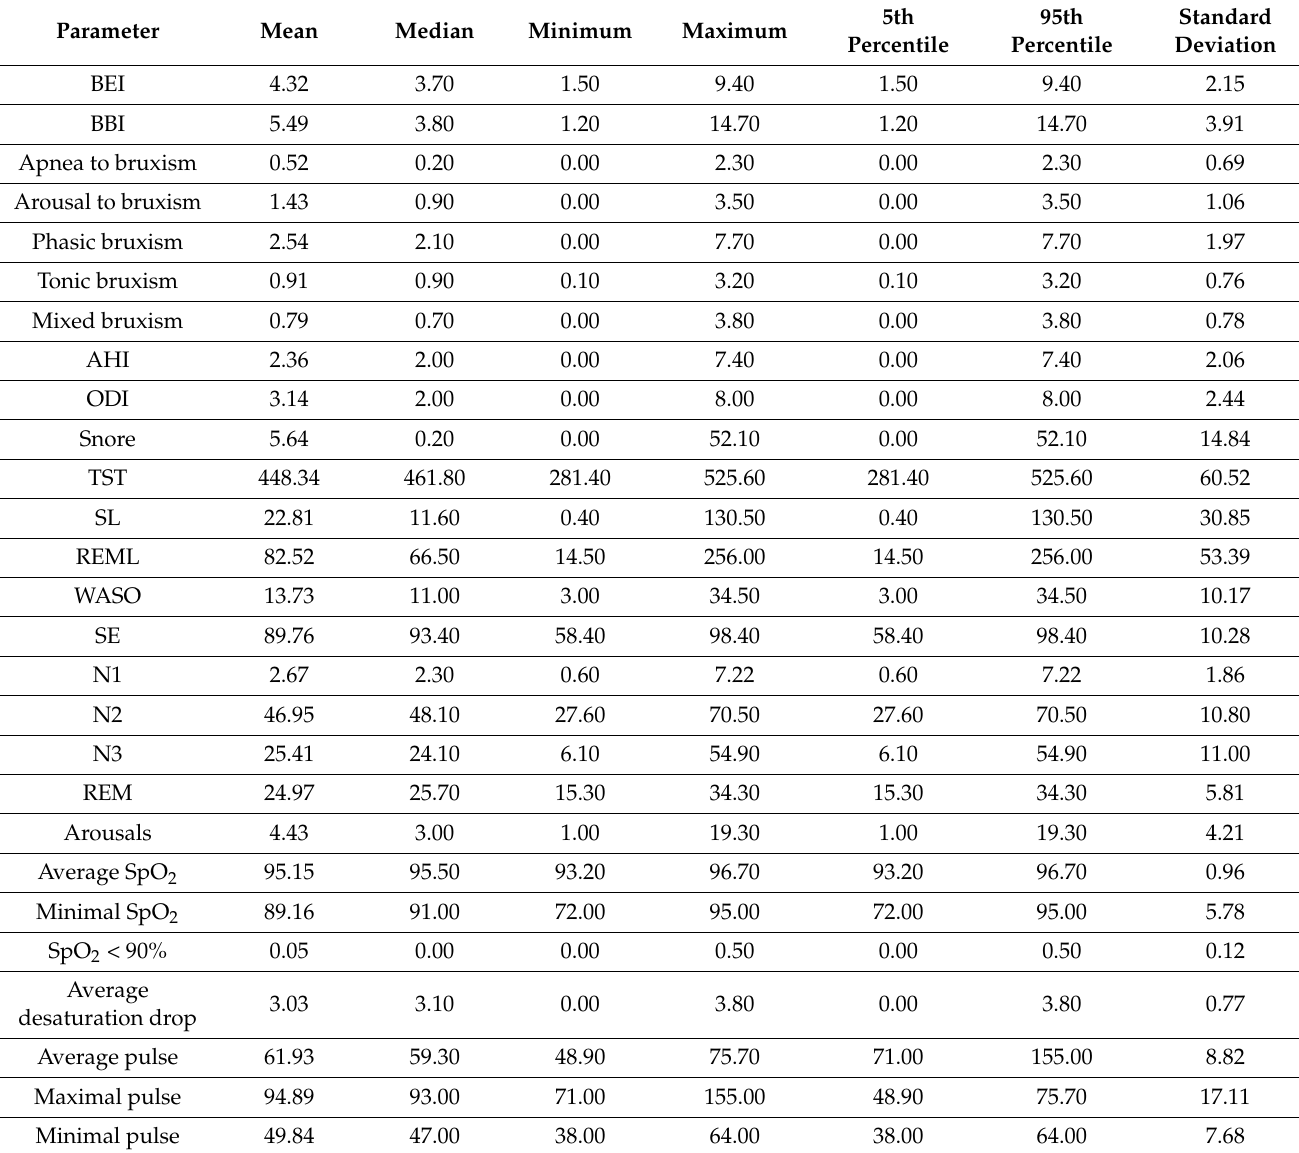
Table 2. Descriptive statistics of stage II vPSG parameters (N =